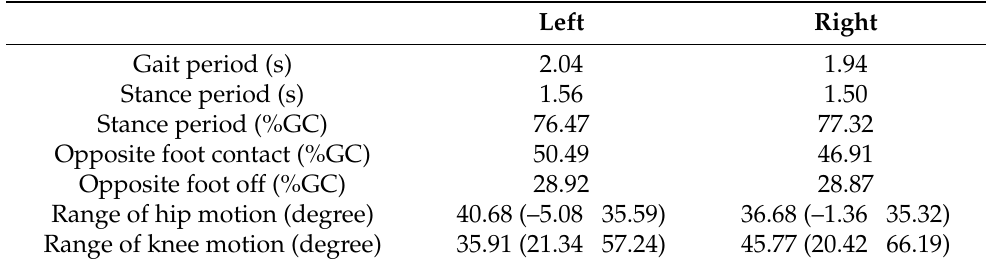
Table 4. Gait parameters of bilateral crutches gait with Angel Legs.